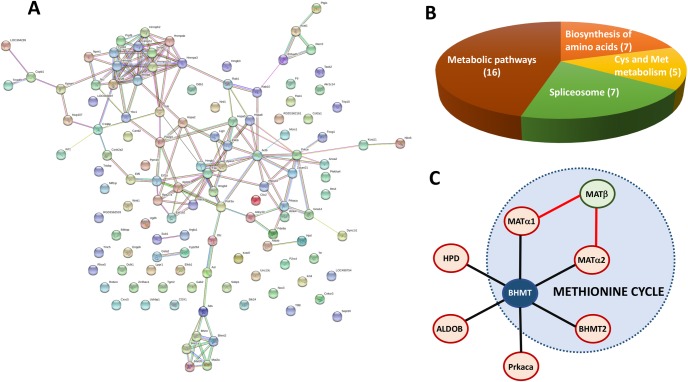
Network analysis using STRING and new validated interaction targets.The whole set of BHMT interaction targets identified by affinity purification/mass spectrometry and yeast two-hybrid was analyzed using STRING set at medium confidence 0.4. (A) The panel shows the network links. (B) Pie chart illustrating the distribution between KEGG pathways with false discovery rates <0.05; The number of proteins identified for each pathway is indicated in parenthesis. (C) Schematic representation of the validated BHMT interactions identified in the present study. Abbreviations: BHMT, betaine homocysteine S-methyltransferase; BHMT2, S-methylmethionine methyltransferase or betaine homocysteine methyltransferase 2; MATα1, methionine adenosyltransferase alpha1; MATα2, methionine adenosyltransferase alpha2; MATβ, methionine adenosyltransferase beta; ALDOB, aldolase b; Prkaca, cAMP-dependent protein kinase catalytic subunit alpha; HPD, 4-hydroxyphenylpyruvic acid dioxygenase.